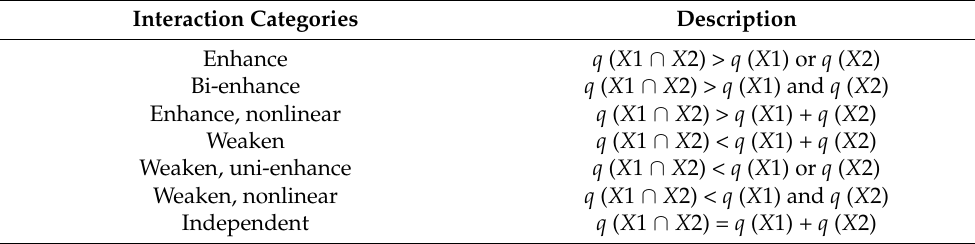
Table 1. Types of interaction between two covariates.